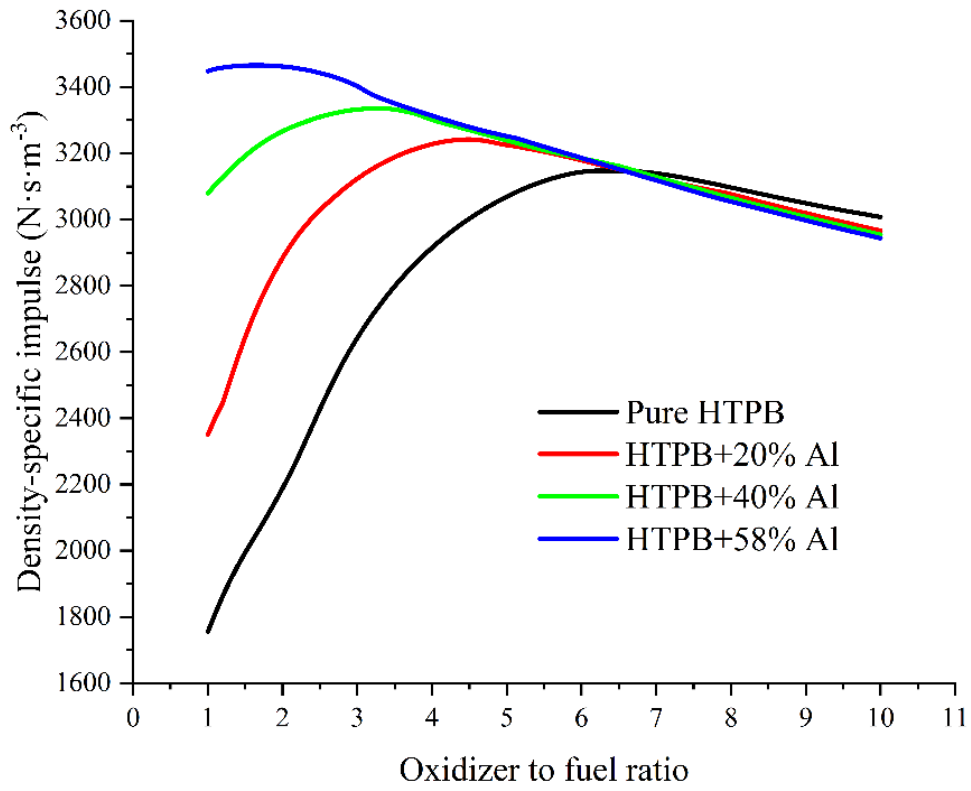
Figure 1. Density-specific impulse changes with the ratio of oxidizer to fuel. Table 1. The chemical reaction mechanism of HRMs.